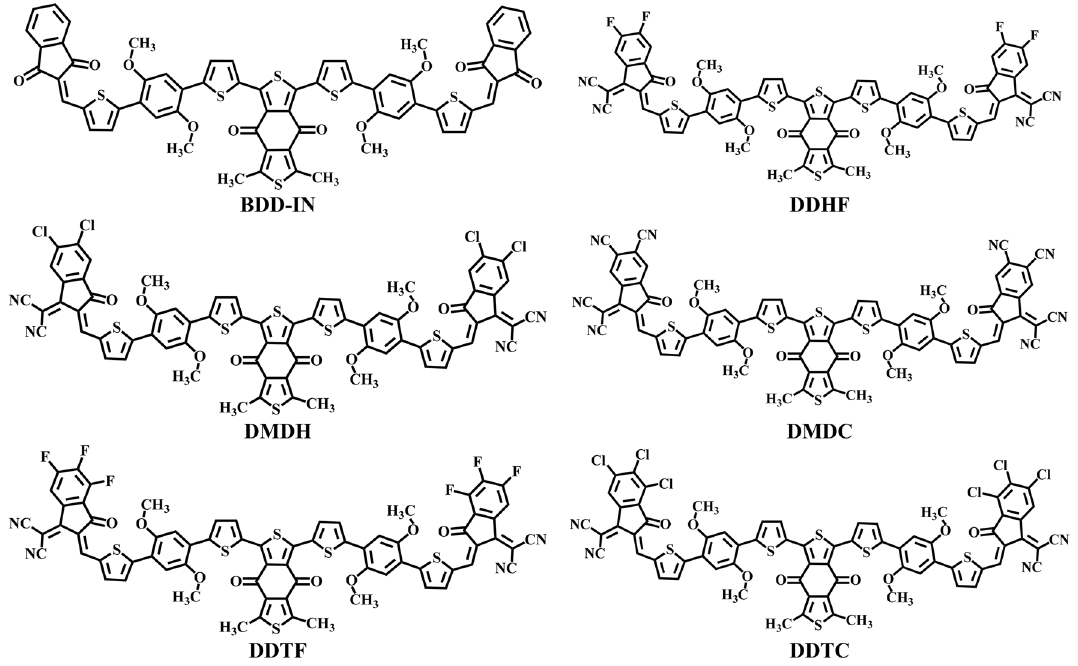
Figure 1. Structures of reference and designed